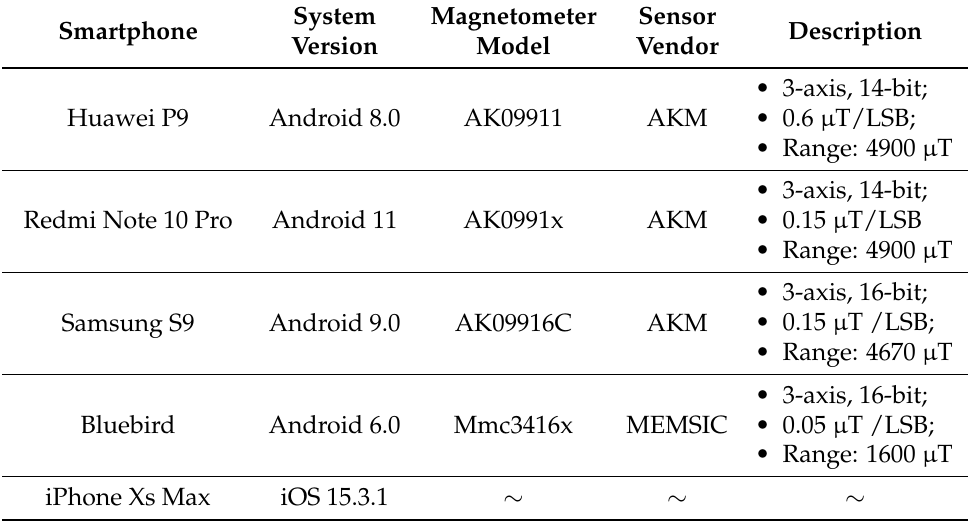
Table 2. Magnetometer information and operating systems for heterogeneous smartphones.